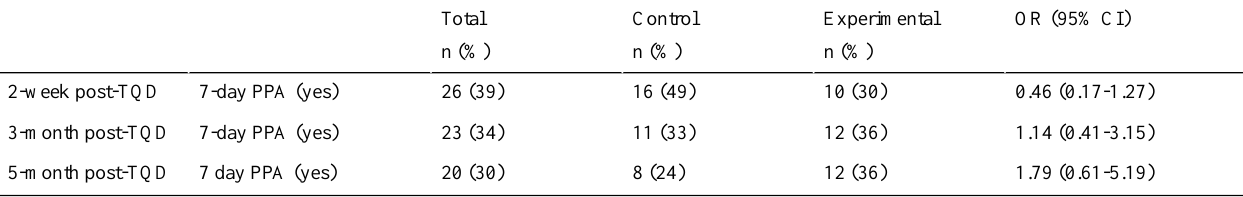
Table 4. Self-reported 7-day point prevalence abstinence rates by follow-up with missing values imputed as smokers